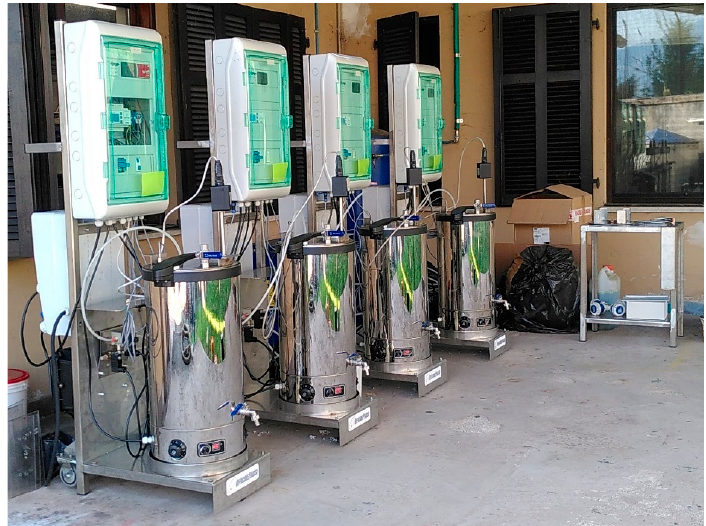
Figure 5. The four designed bench-scale bioreactors in action.